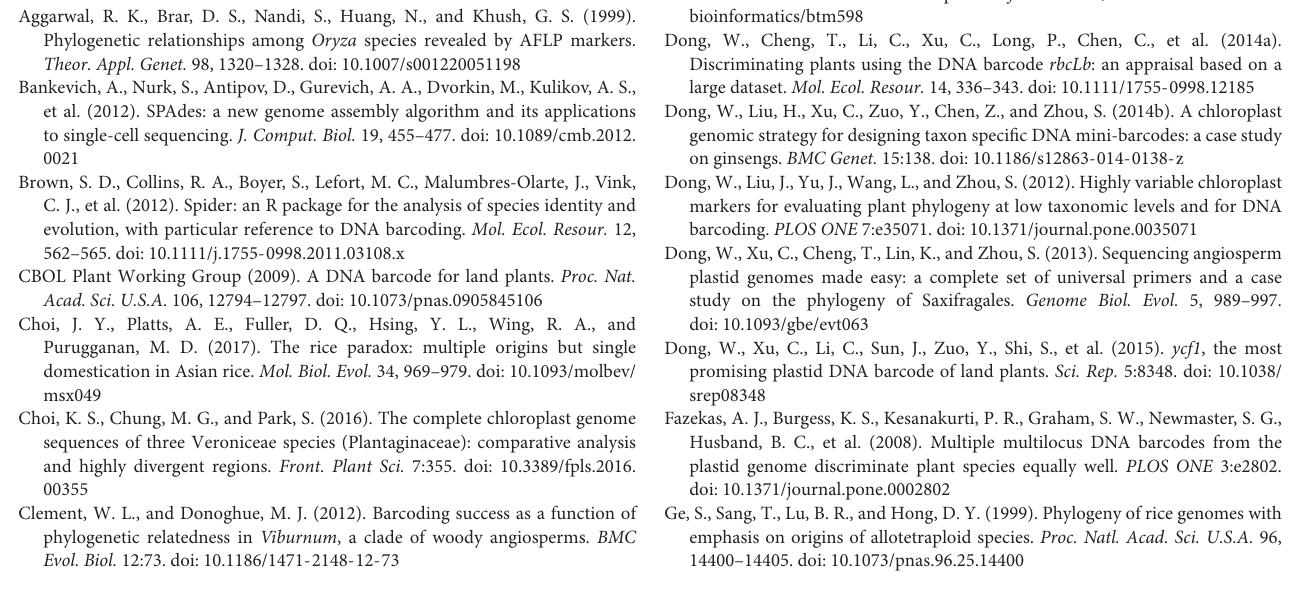
TABLE S1 | Numbers of nucleotide substitutions and sequence distances in 18 complete chloroplast genomes. The upper triangle shows the number of